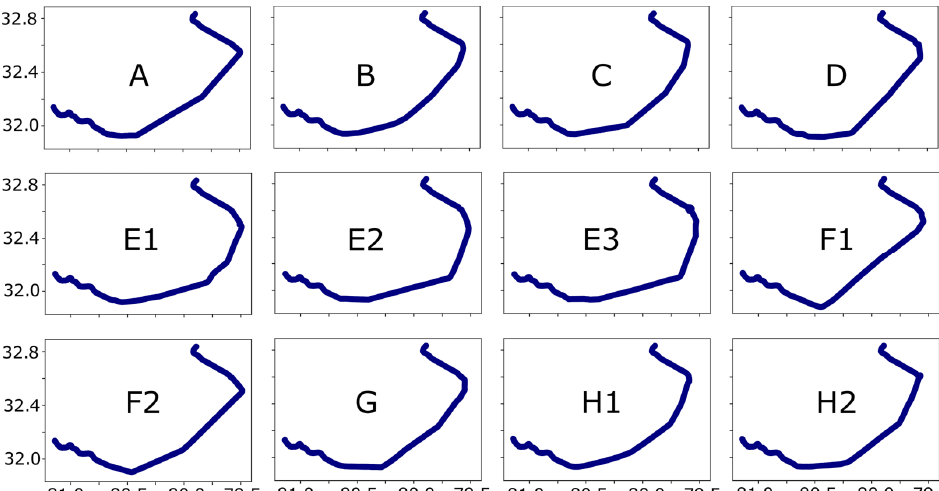
Figure 10. The routes for individual voyages. The x –axis represents longitude, y –axis latitude, for each of the subplots.